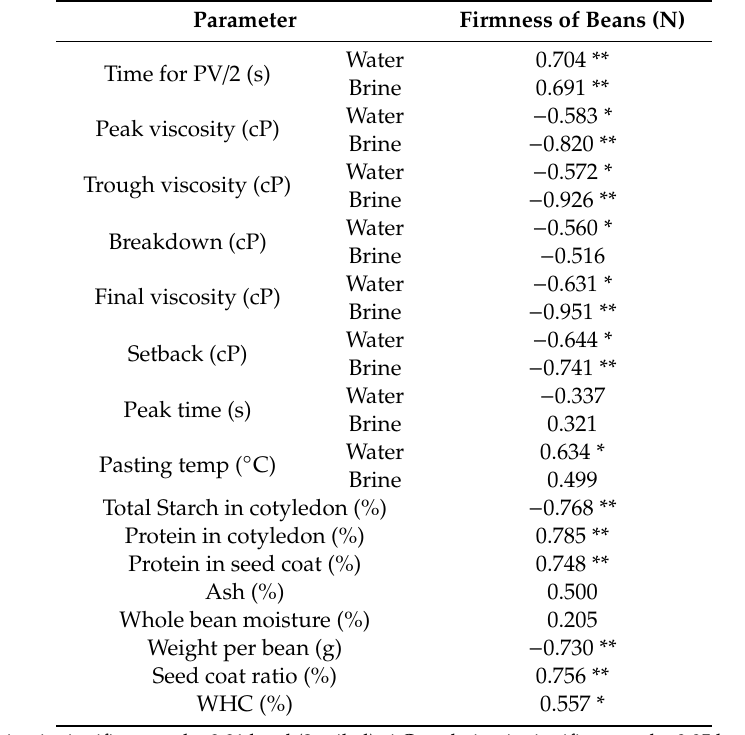
Table 7. Correlations of textural properties of canned beans with the pasting properties at high temperature (130 ◦ C) and compositional and physical measurements of dry seeds.